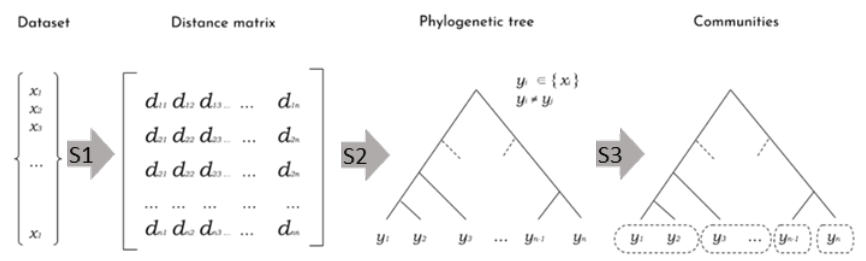
Figure 1. The tree-steps of the pipeline DAMICORE (reproduced from